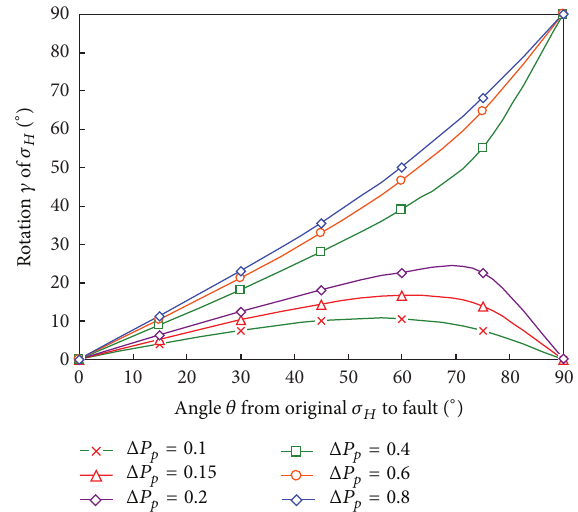
Figure 2: The relationship between deflected angle and the angle 𝜃 .